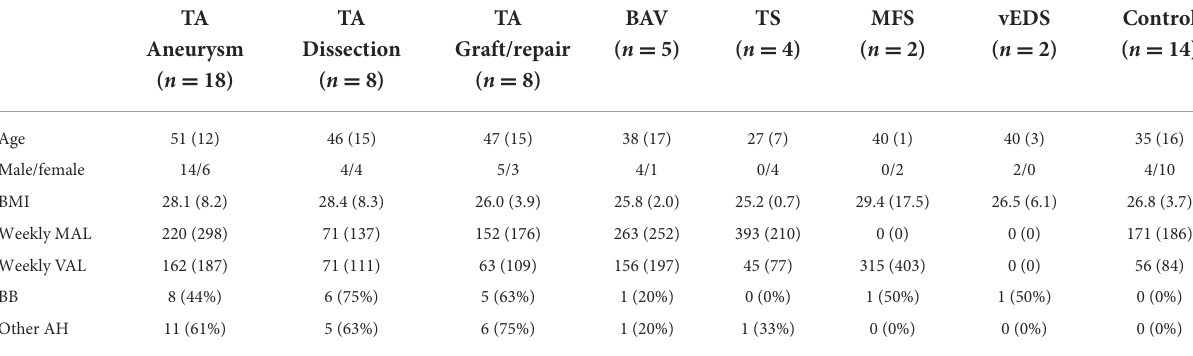
TABLE 1 Demographic characteristics of study